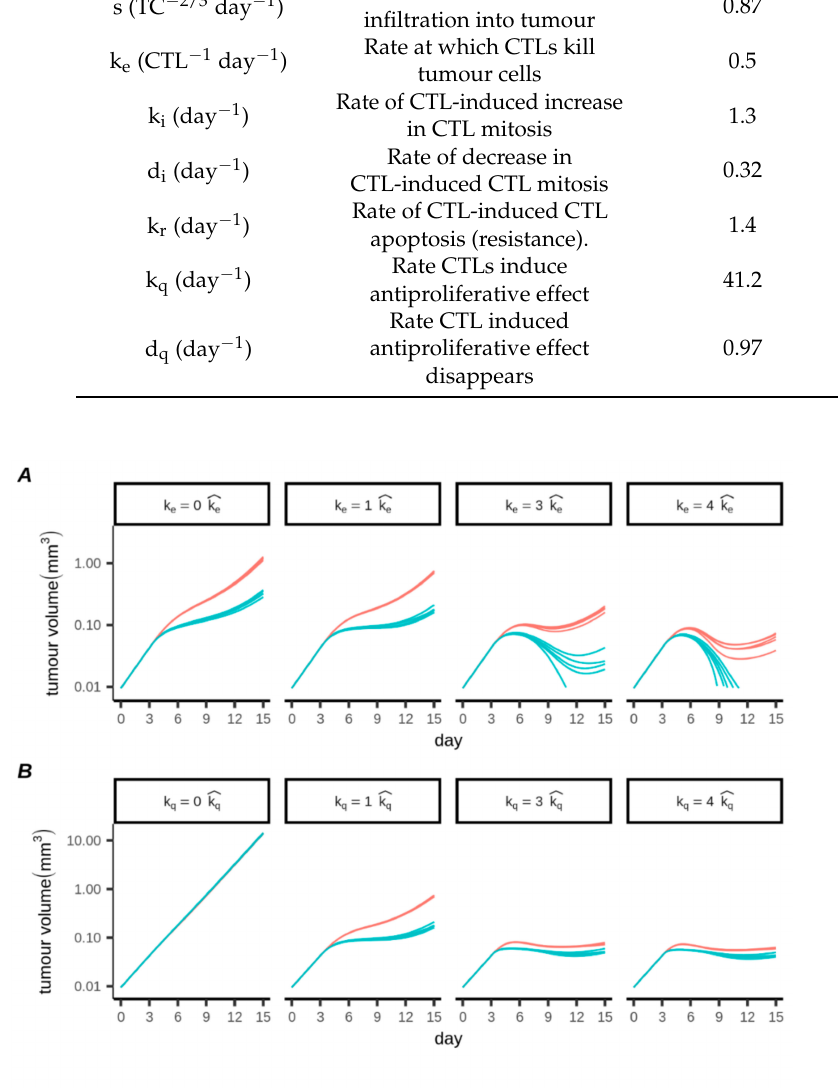
Figure 4. Relative impacts of antiproliferative and killing effects of adoptively transferred CTLs. ( A , B ) Impact of varying the killing rate (k e ; A ) and the rate parameter for induction of antiproliferative effect (k q ; B ). Using the best fitting parameter sets, both rates were multiplied by a factor of 0, 1, 3 or 4 (indicated by columns). Parameters with hats represent best fitting